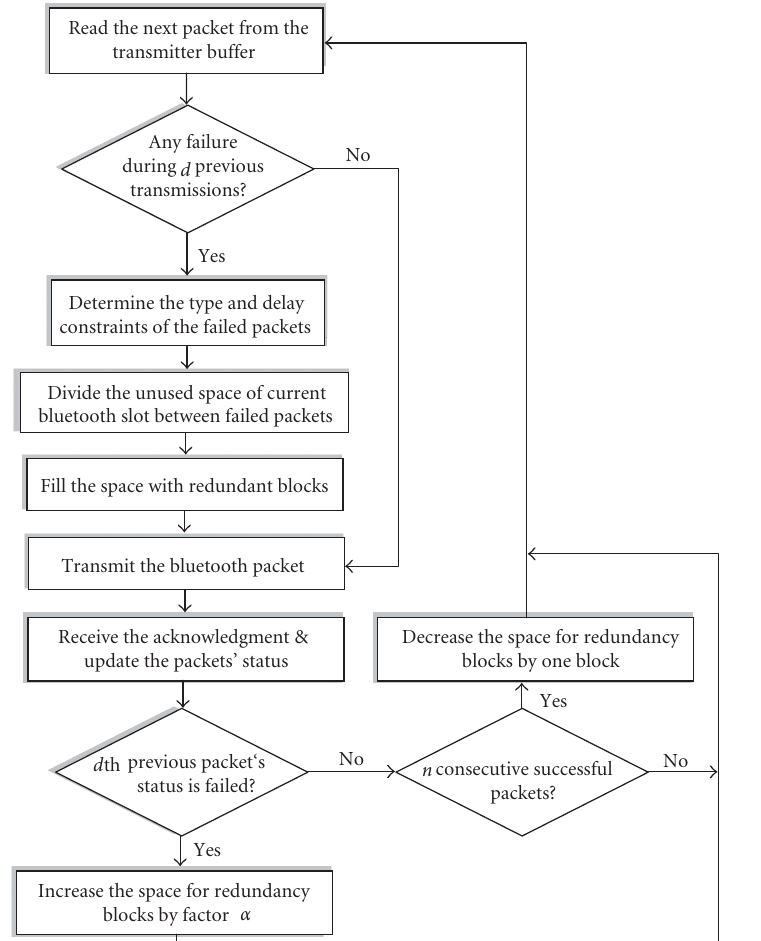
Figure 3: Block-based rateless coding algorithm, where a packet failure is a failure to reconstruct a packet with redundant